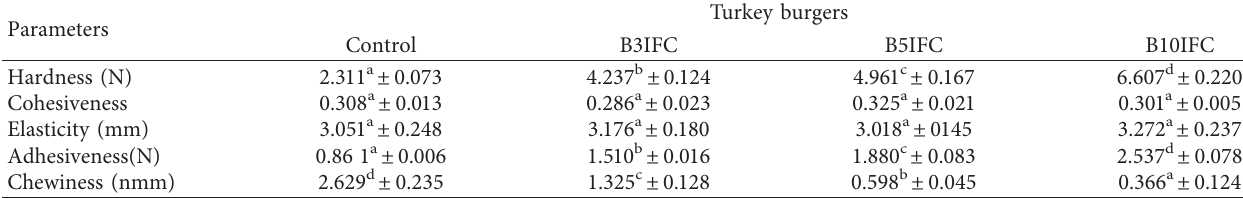
Table 6: Textural properties of raw turkey burgers formulated with IFC 24h after conservation at 4 ° C.